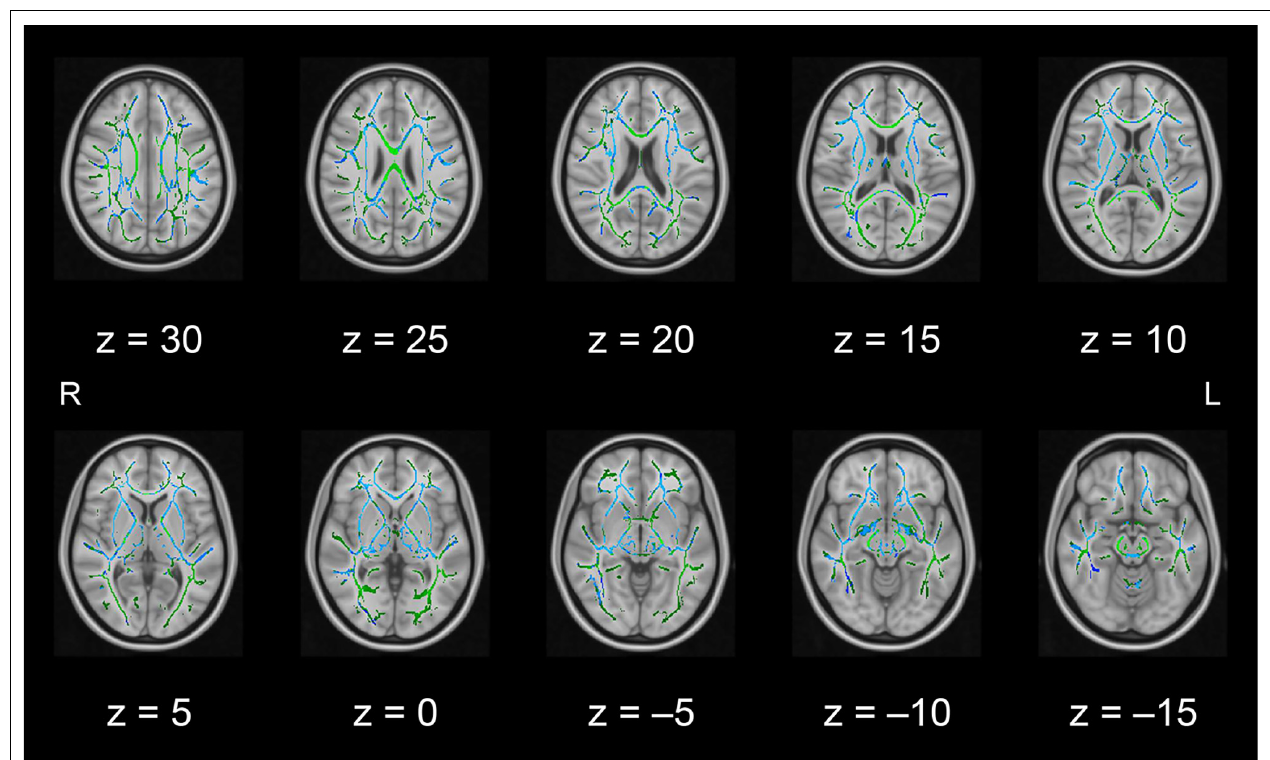
FIGURE 4 | White matter fiber tracts showing significantly lower RD values in the intervention group than in the control group (displayed in blue). The results are overlaid on the mean FA skeleton (shown in green) and the standard MNI152 T1 1-mm 3 brain template. The value of z in the horizontal plane represents the MNI z -coordinate. Abbreviation: FA, fractional anisotropy; L, left; MNI, Montreal Neurological Institute; R, right; RD, radial